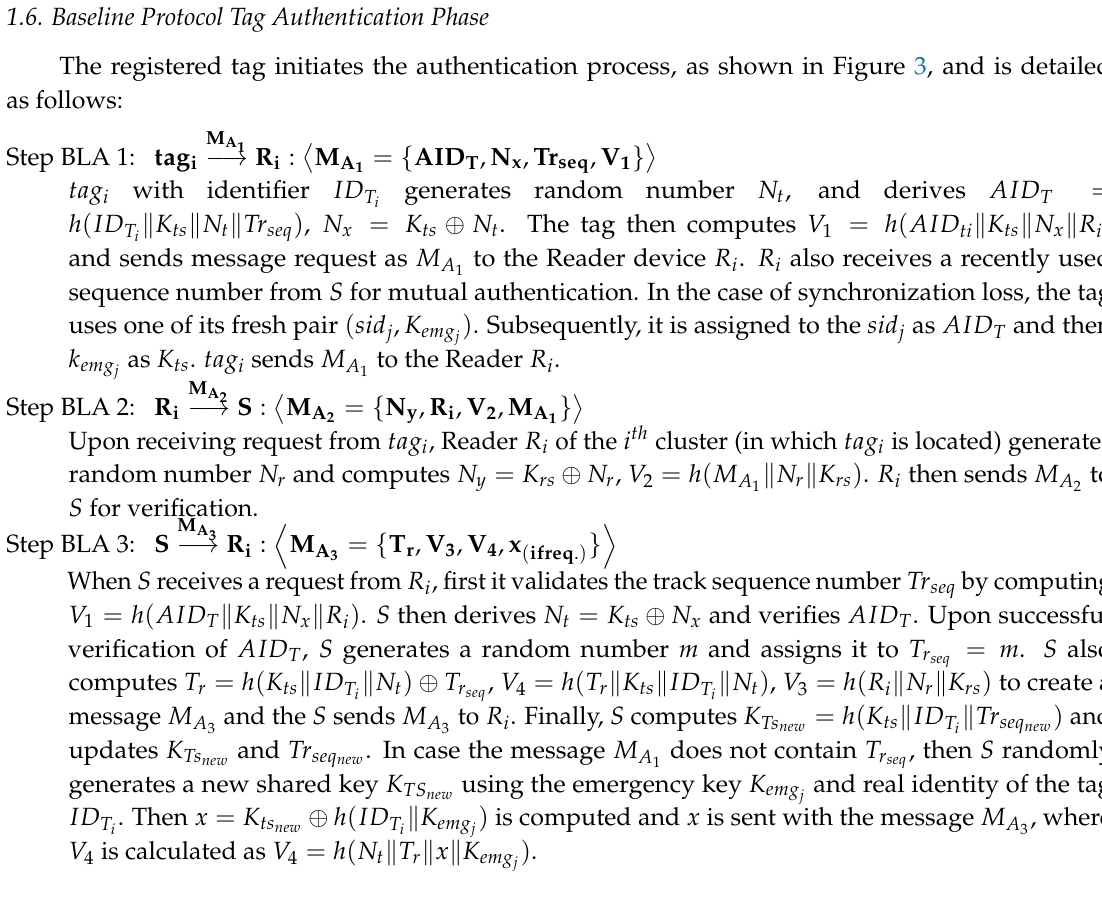
Figure 2. Gope-Hwang’s proposed registration